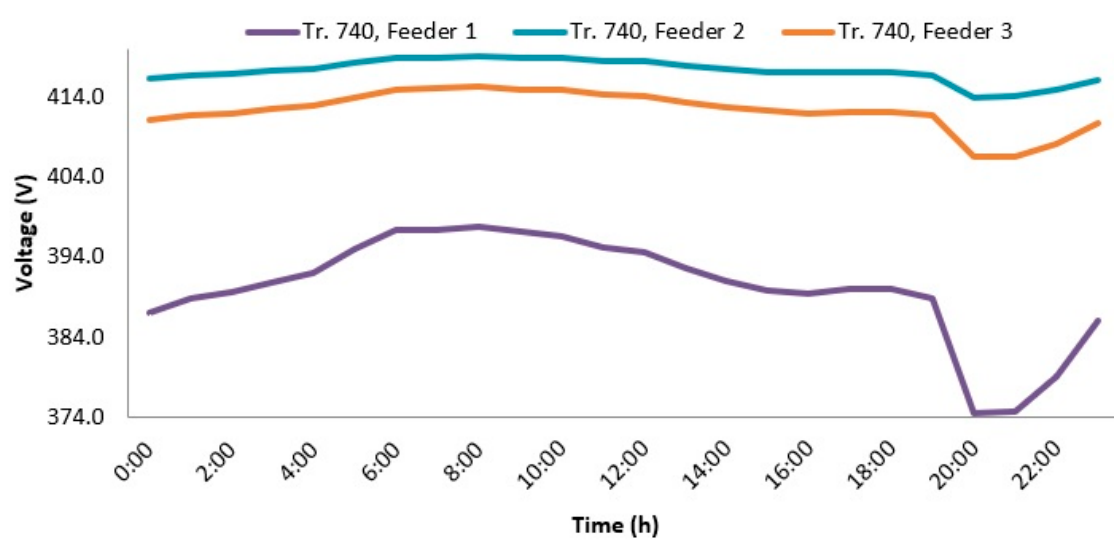
Figure 14. Voltage profile at the end of Transformer 740 in summer with 60% EVC and arrival time charging.